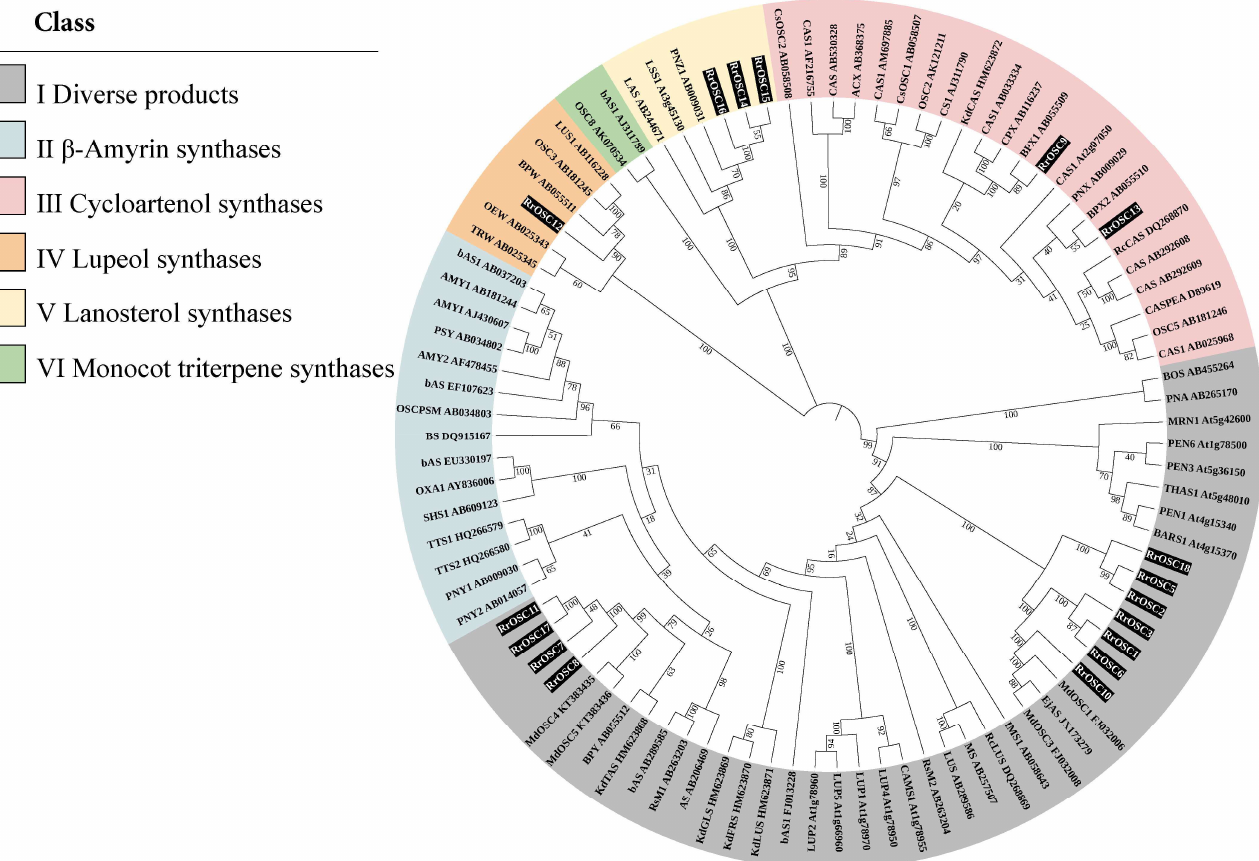
Figure 1. Phylogenetic analysis of 95 oxidosqualene cyclases ( OSCs ) of different plant species. The phylogenetic dendrogram was generated using the neighbor-joining method with 1000 bootstrap replicates (numbers in branches). Groups were distinguished with different colors and OSCs of Rosa rugosa ( RrOSCs ) were highlighted. The information on plant species and corresponding OSCs are listed in Table S2.